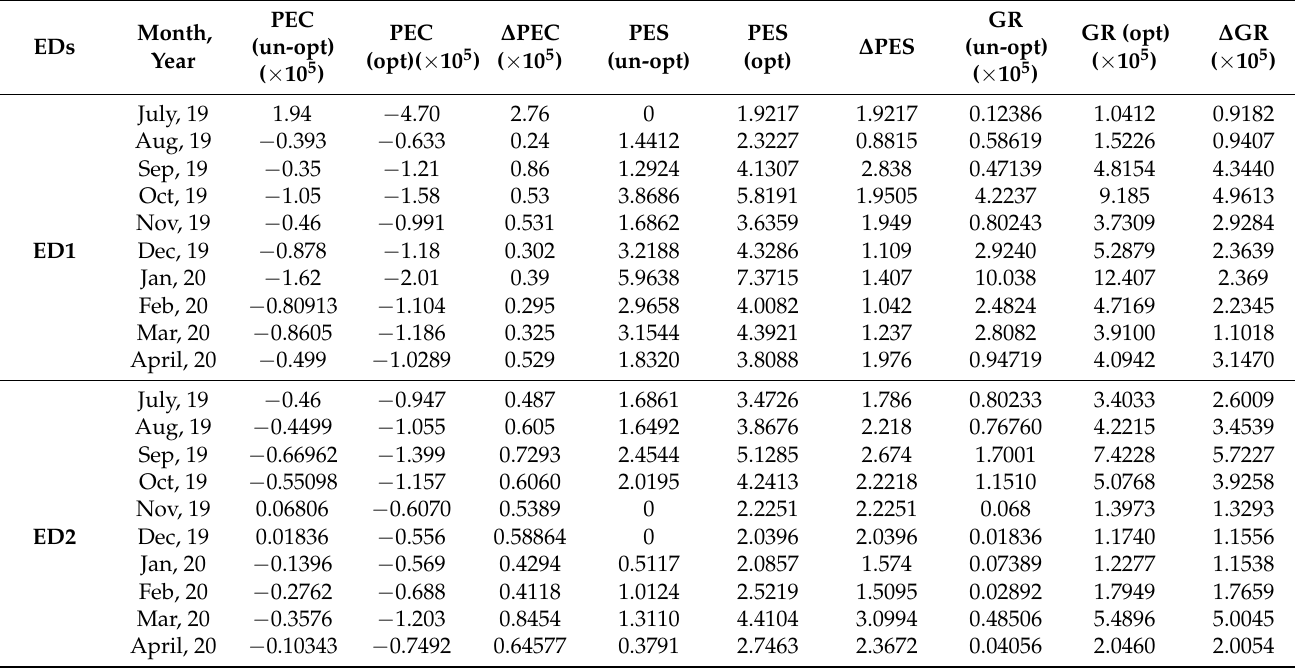
Table 5. Comparative analysis of unoptimized and GA optimized